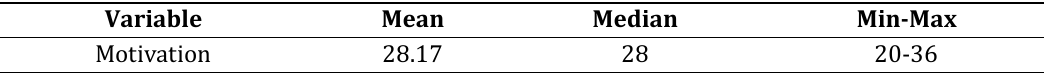
Mean Score of Motivation among Professional Nurse Professional Study Program Students in Jember